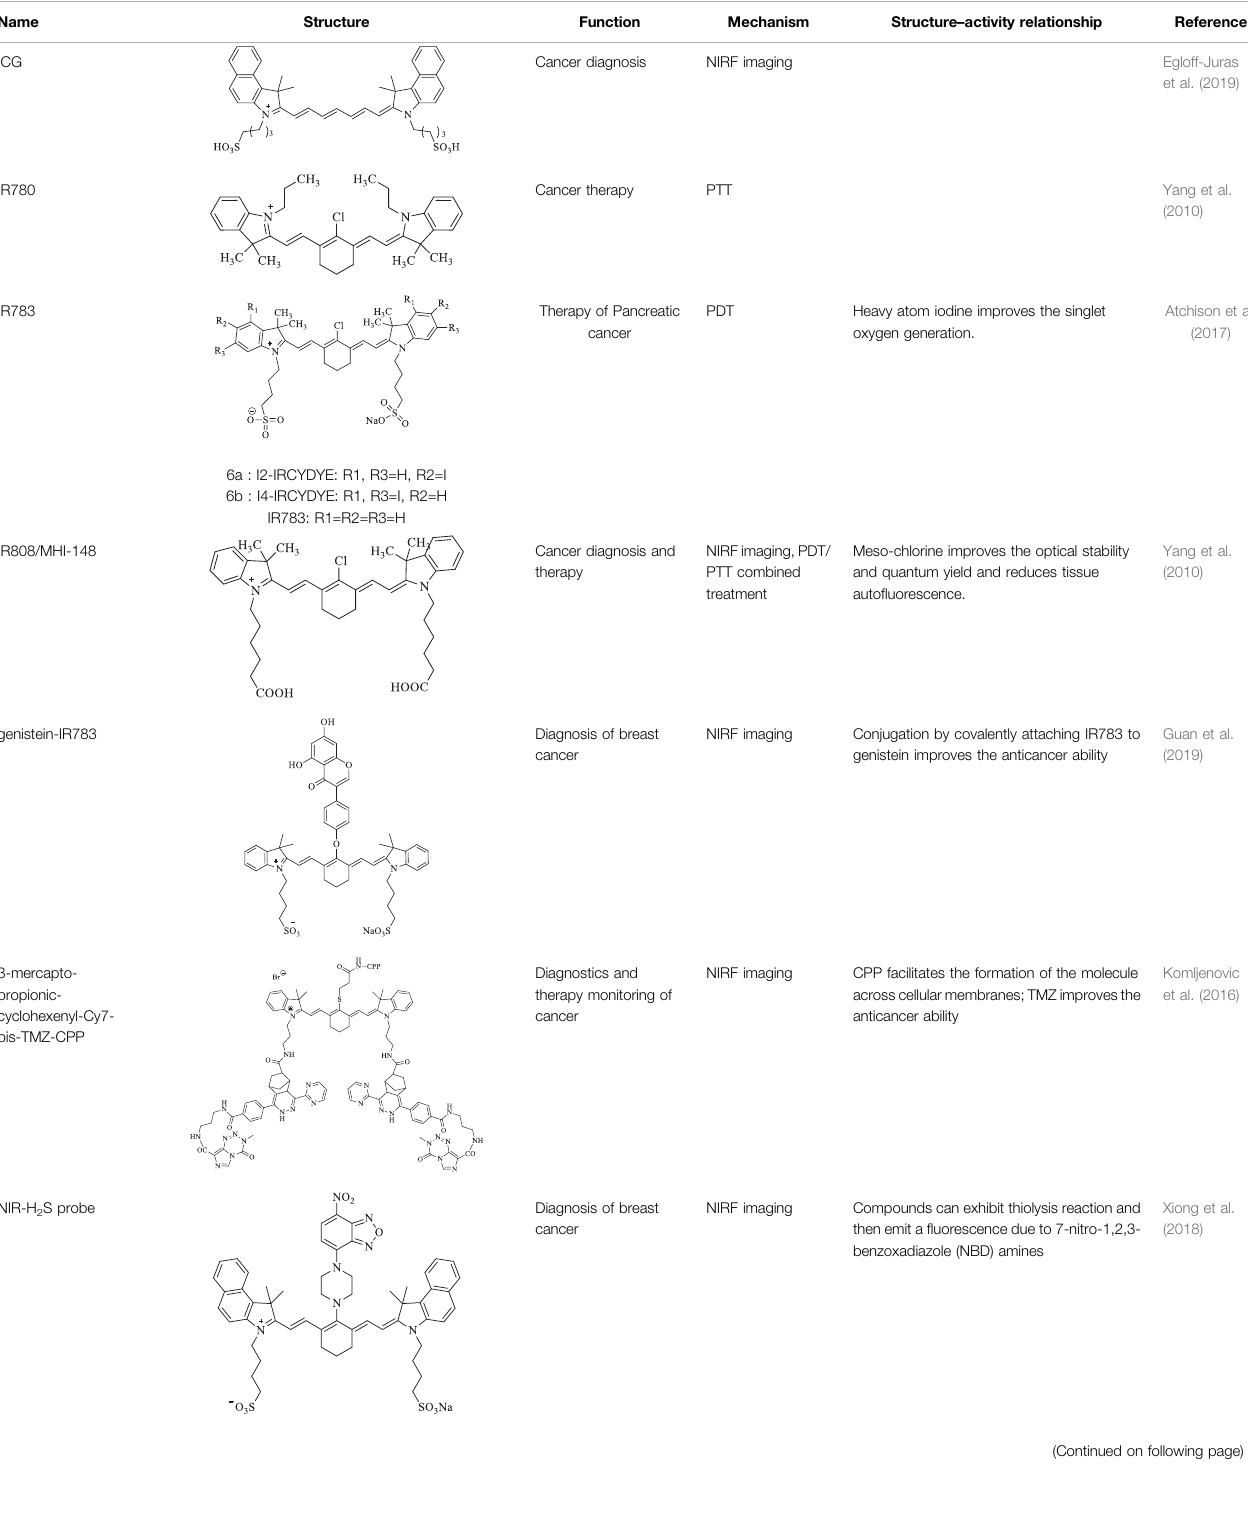
TABLE 1 | Information on the structure and function of Cy7 and its derivatives.